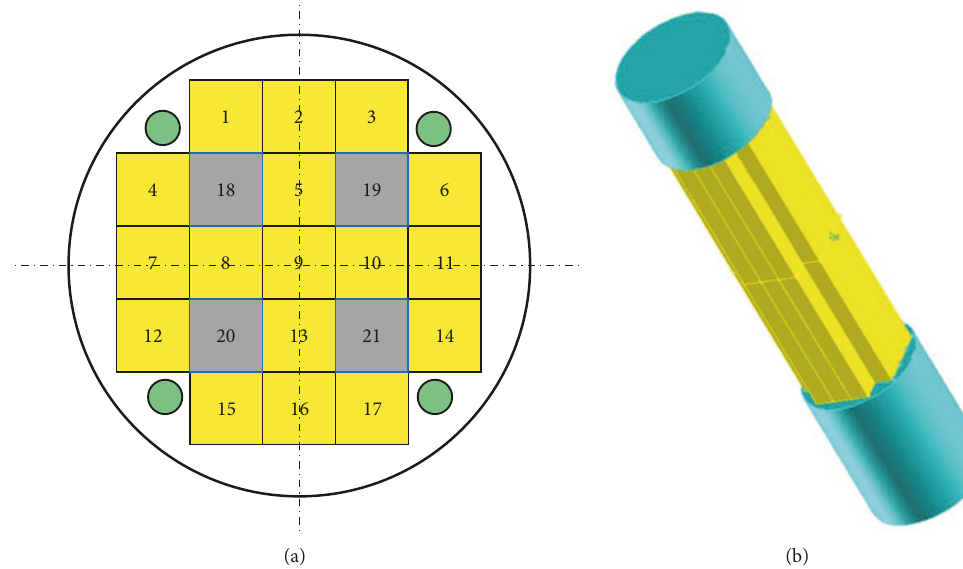
Figure 6: CARR simulation model: (a) assembly configuration of CARR; (b) outline of the geometry